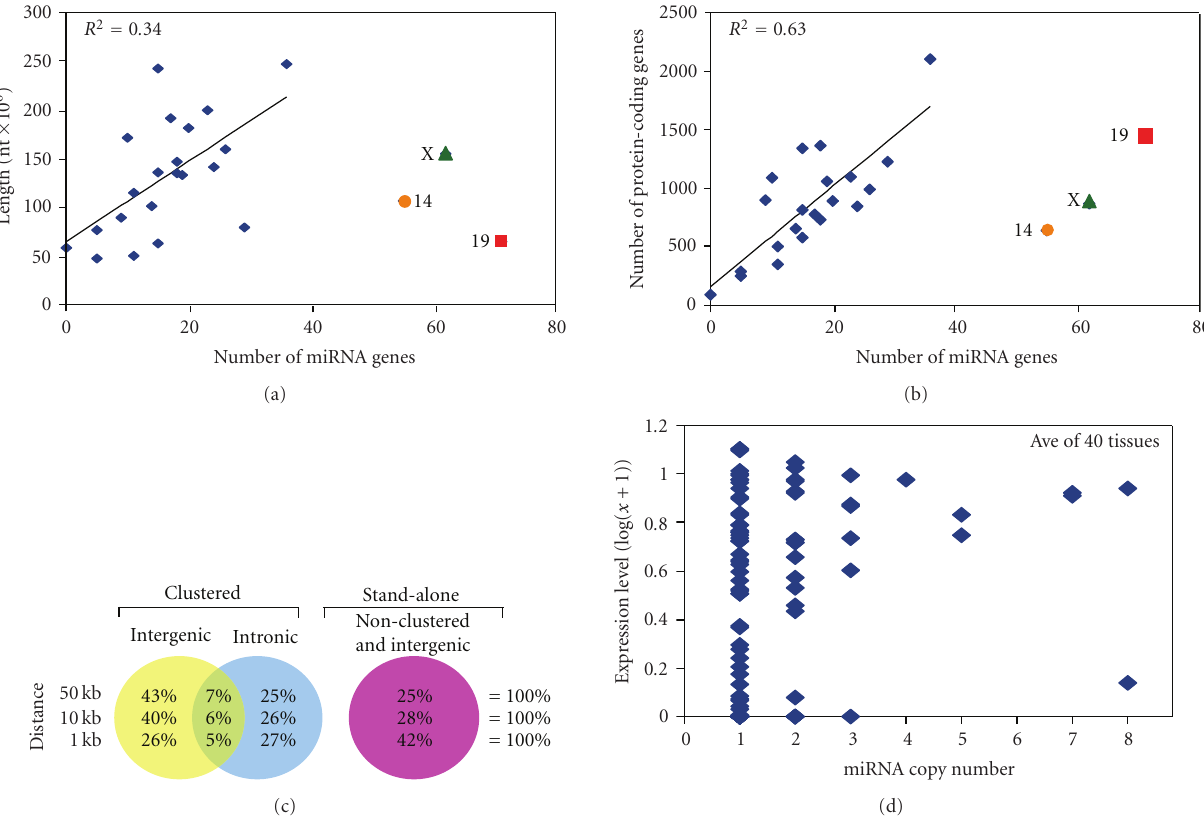
Figure 2: Genomic organization of miRNA genes and their expression. The number of miRNA genes correlates with chromosome length (a) and the number of protein-coding genes (b). Outliers chromosomes 14, 19, and X are indicated. When removing these three chromosomes the number of miRNA genes aligns well on the regression line ( R 2 indicated). (c) Proportion of miRNA genes hosted in Introns—Intronic (based on Refseq genes), Clustered on the same genomic strand, or Stand-alone miRNAs. Overlapping intronic and clustered miRNAs are also indicated. Each row refers to 50kb, 10kb, and 1 kb distance between paired genes on the same strand. It was shown that clusters of size 3kb give a large proportion of clusters (27%) with little change when increasing pairwise distance to 10 kb [54]. Diagrams are based on data from Refseq. (d) Human miRNA copy number was plotted against the average miRNA expression level of 40 Human tissues [60]. A similar plot of another dataset [55] gave comparable results (data not